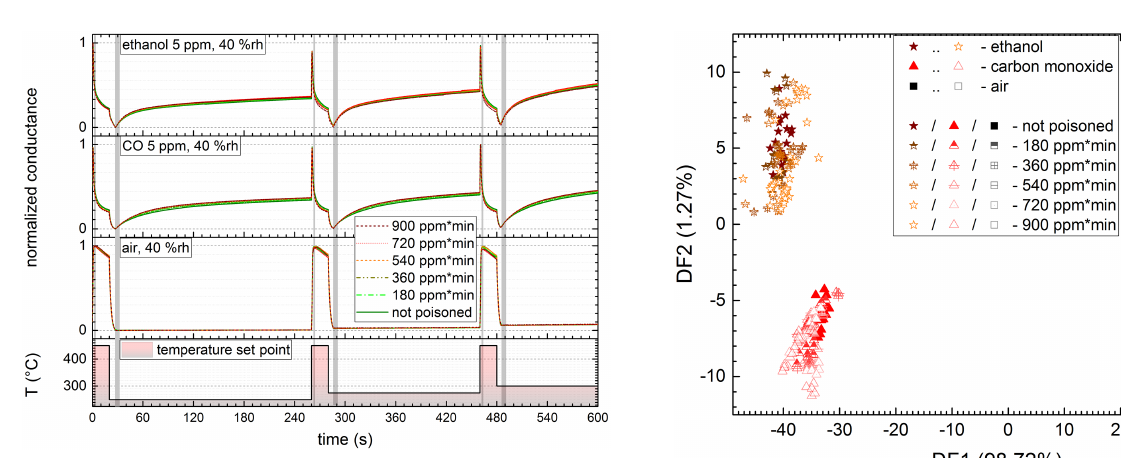
Figure 8. LDA plot showing the discrimination of different gases based on normalized data from different poisoning states of sen- sor 1. The DFs were calculated with data acquired before poisoning (solid symbols), and applied to data from all poisoning states. The 12 features used for this LDA are based on normalized conductance values, i.e. a linear projection of all conductance values of a tem- perature cycle to the interval [0, 1] (cf. Fig.